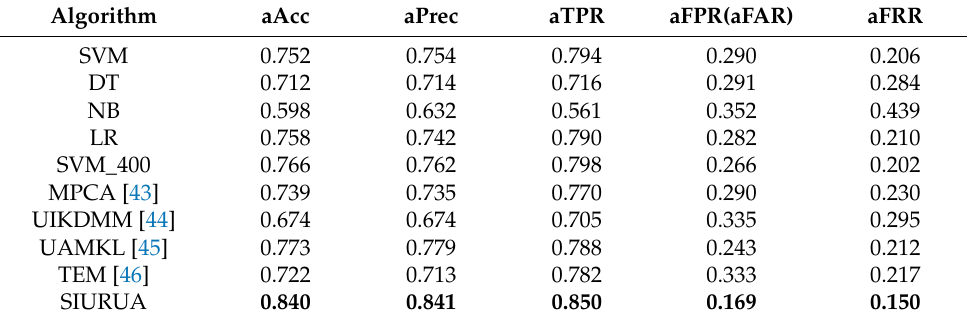
Table 6. Comprehensive comparison of the above methods.